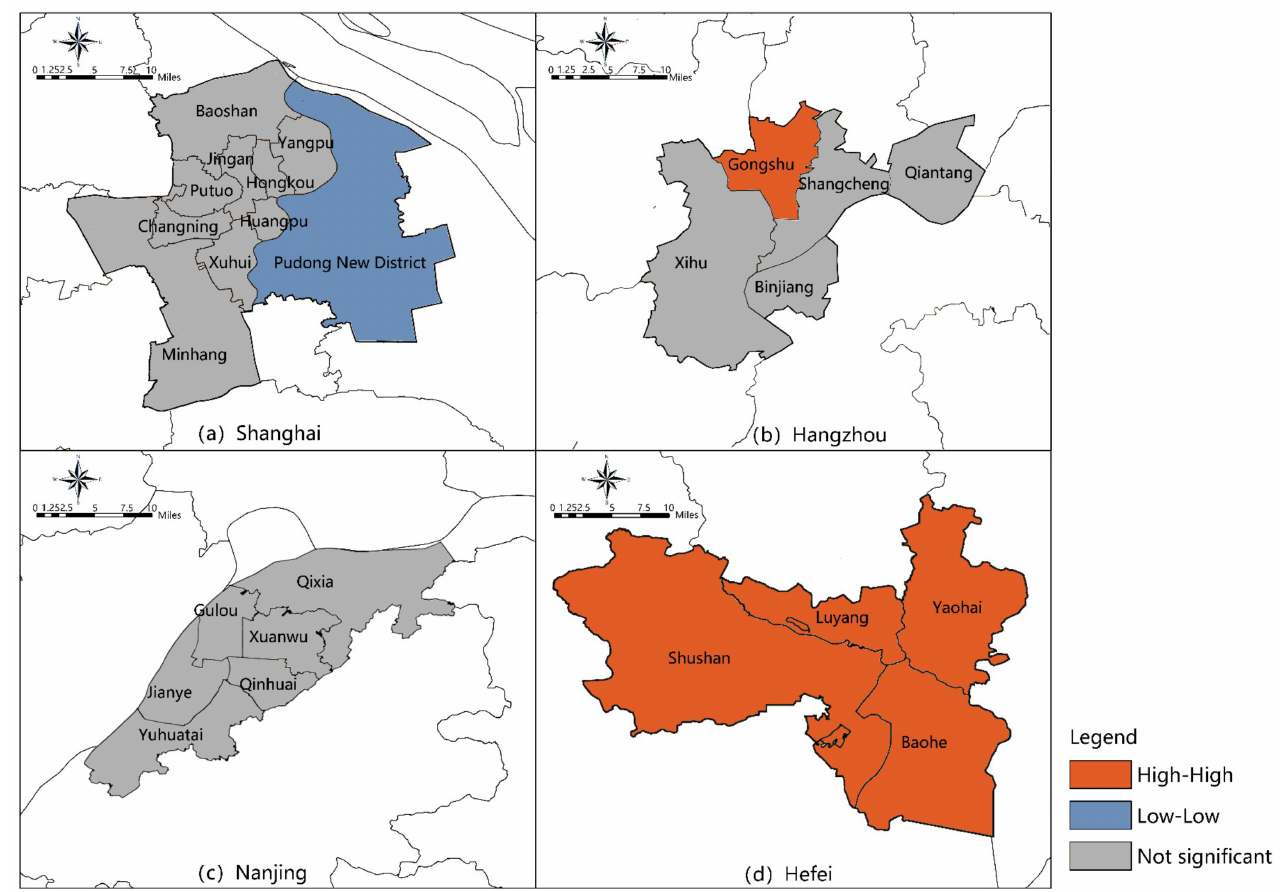
Figure 5. The LISA map of the CLI of the administrative districts in the main urban areas of the four central cities in the